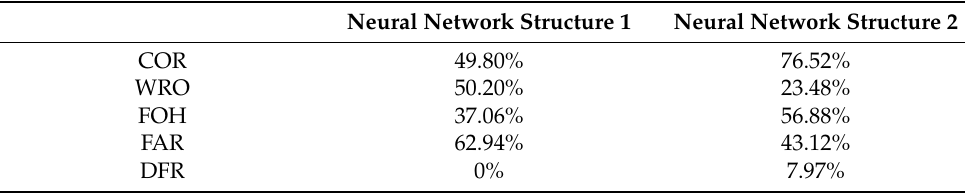
Table 7. Statistics of judgment results of icing